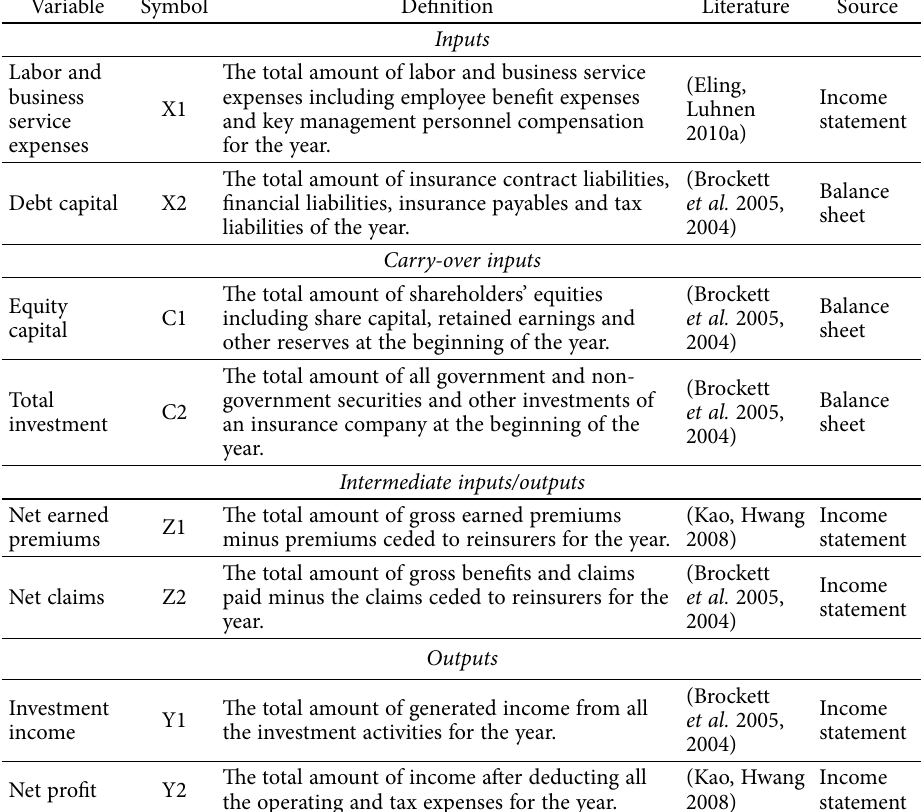
Table 1. Definitions of input, carry-over, intermediate and output